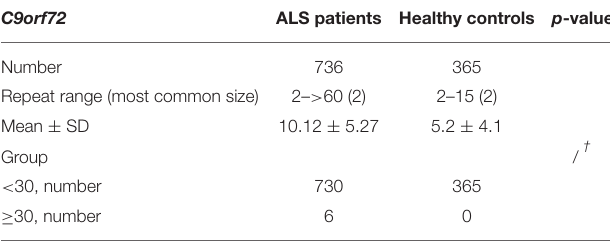
TABLE 1 | Analysis of GGGGCC HREs in the C9orf72 gene in ALS patients and controls.